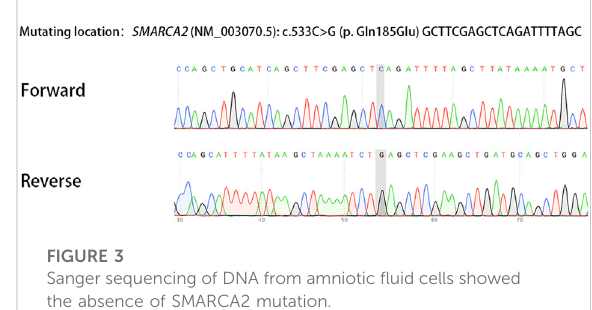
FIGURE 3 Sanger sequencing of DNA from amniotic fl uid cells showed the absence of SMARCA2